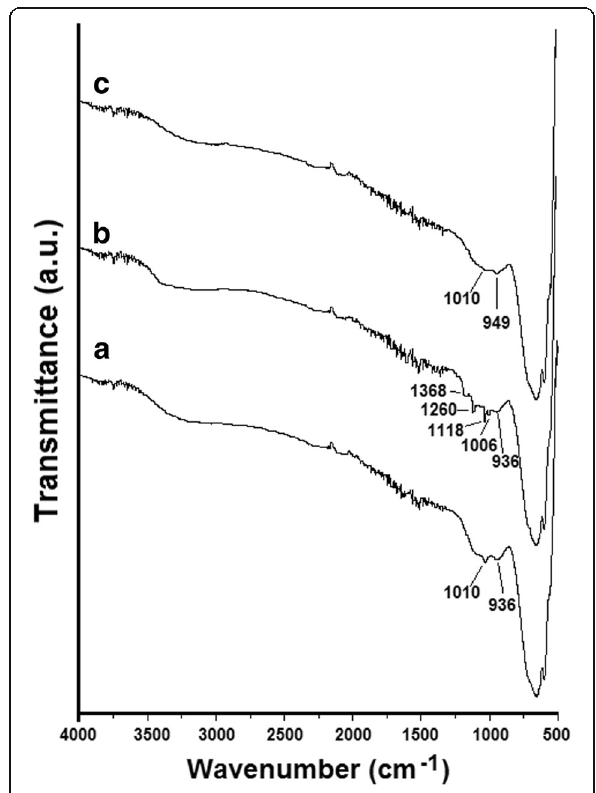
Fig. 11 FTIR spectra of a 0.3 Sb 2 S 3 -HEC, b 0.3 Sb 2 S 3 -HEC adsorbed by MO, and c 0.3 Sb 2 S 3 -HEC adsorbed by MB,